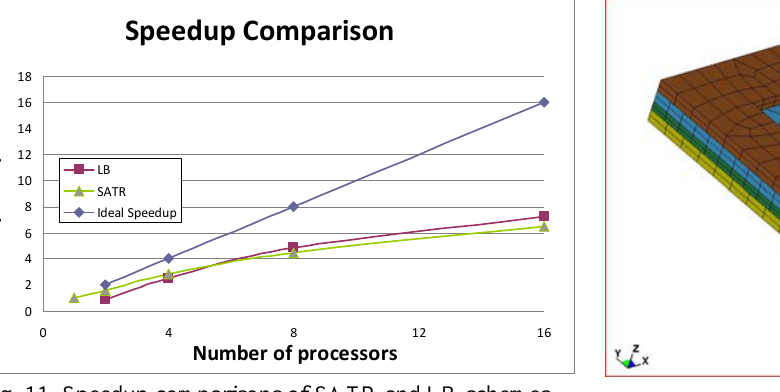
Fig. 11. Speedup comparisons of SATR and LB schemes for 3-DV case